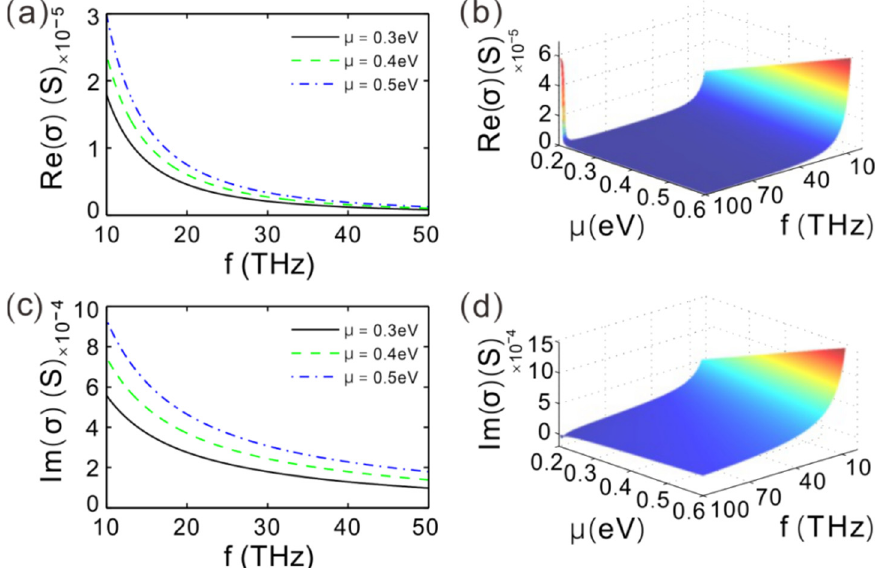
Figure 4. ( a , c ) Real part and imaginary part of graphene surface conductivity varying with the light frequency for different values of chemical potential, respectively. ( b , d ) Real part and imaginary part of graphene surface conductivity by modulating simultaneously the light frequency and chemical potential, respectively.